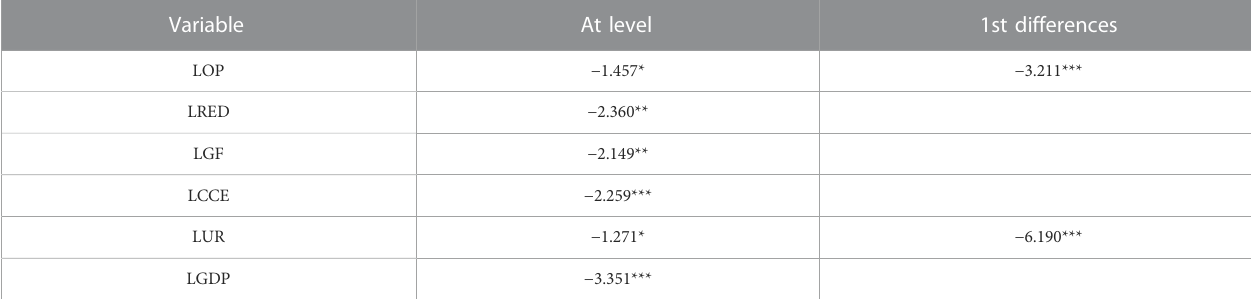
TABLE 5 Results of CIPS unit root test.